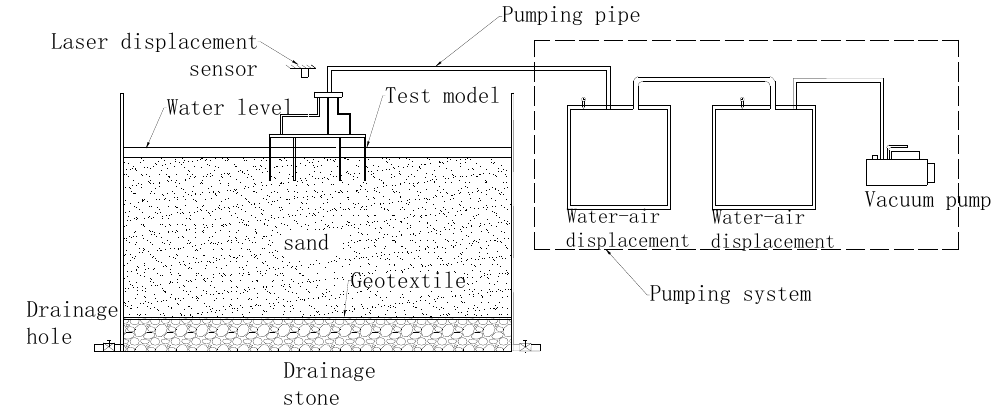
Figure 3. Schematic diagram of the test.